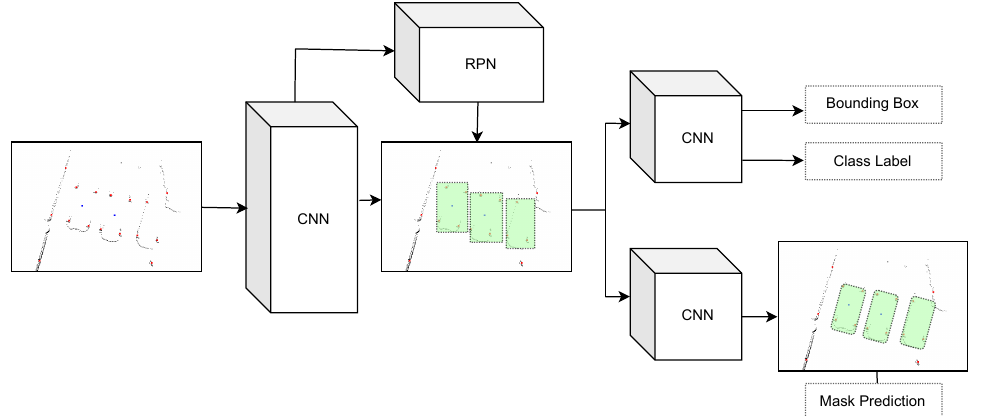
Figure 7. The training pipeline from Figure 3 is used to provide training data and labels to our neural network, in our case Mask R-CNN. The network consists of an initial convolutional neural network (CNN) in combination with a region proposal network (RPN) to identify detection candidates (highlighted in green). The result is run through a further CNN for bounding box prediction and to estimate the class label, and it is run through another CNN for final mask prediction. The masks are projected back to the real-world as defined in Section 4.4. Our pipeline allows for the training process to take place without human annotation effort, and it can be made more robust by our training pipeline’s weather